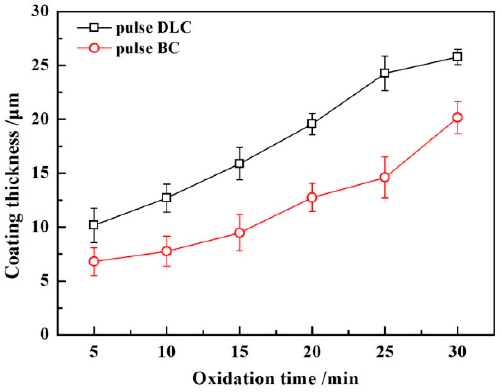
Figure 6. The cross-section morphology of MAO coatings in power supply mode of pulse bipolar current ( a ) and pulse with a discharge loop current ( b ).